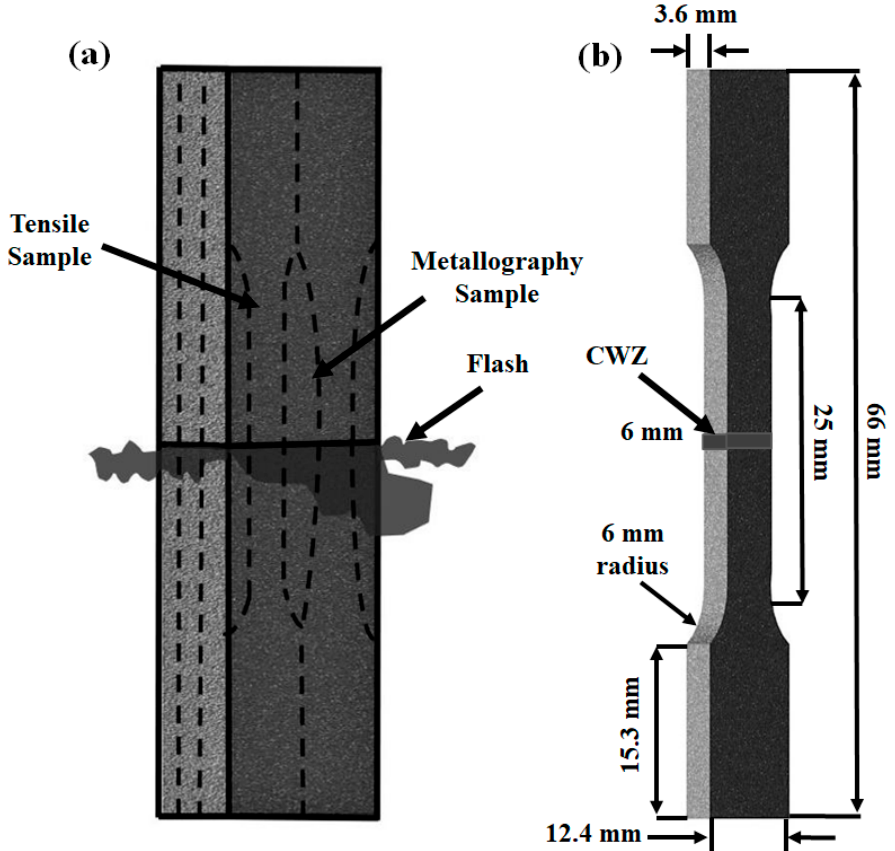
Figure 2. ( a ) Schematic representation showing the electrical discharge machining (EDM) plan for extracting the tensile and metallography samples from the welds and ( b ) geometry of the tensile samples.